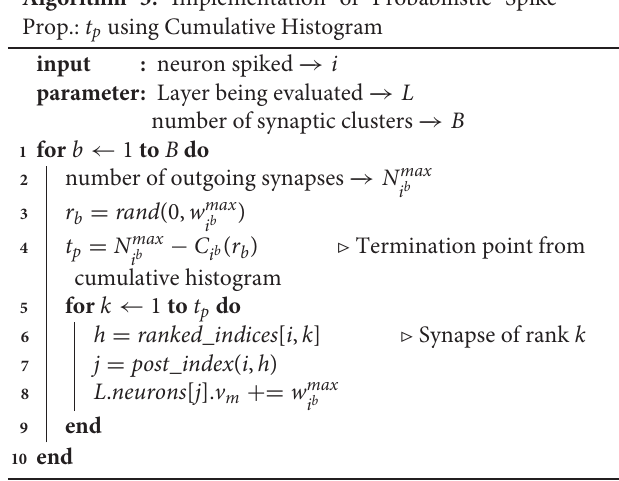
Algorithm 3: Implementation of Probabilistic